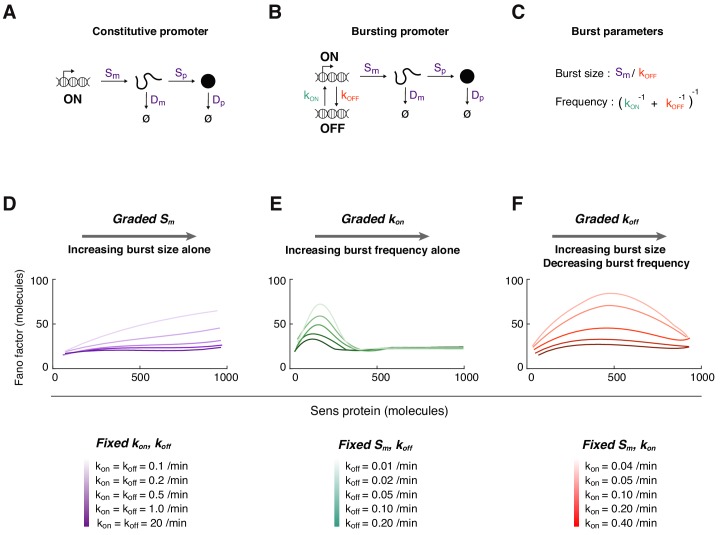
Mathematical modeling of Sens protein noise.(A) The model of gene expression with a constitutively active promoter. (B) The two-state model with a promoter having distinct on and off states, and independent rate constants for state conversion (see also Figure 3—figure supplements 1–2). (C) The relation between transcription rate constants and transcription burst frequency and burst size. (D-F) The Fano factor derived from simulations of the two-state model. In each panel, a different transcription rate constant is varied to generate a range of Sens protein output. Trend lines were generated by smoothing the Fano factor profiles obtained from binning 5,000 simulated cells. (D) The rate constant Sm is systematically varied from 0.1 to 1 mRNA/min. Rate constants kon and koff are fixed at the values shown for each simulation curve. The promoter switches rapidly at high values of kon and koff such that the Fano factor is similar to one from a constitutively active promoter (dark purple line). (E) The rate constant kon is systematically varied from 0.025 to 10 min-1. Rate constant Sm is fixed at 0.25 mRNA/min, and koff is fixed at the values shown for each simulation curve. (F) The rate constant koff is systematically varied from 0.025 to 3 min-1. Rate constant Sm is fixed at 0.5 mRNA/min, and kon is fixed at the values shown for each simulation curve.Figure 3—source data 1.Rate parameters used in modeling.Default parameter values (indicated in bold) were used for all simulations unless noted.